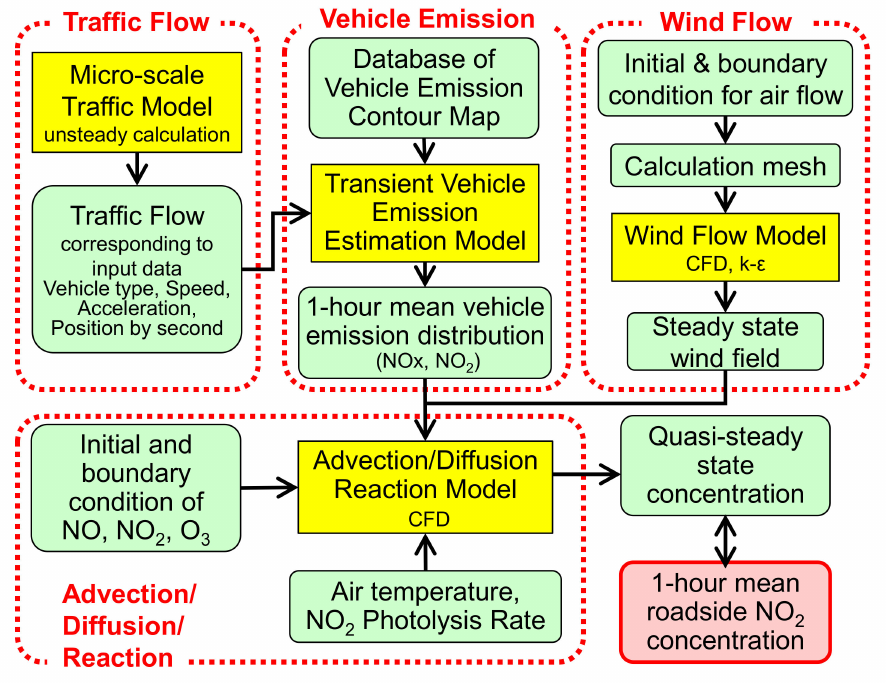
Figure 17. Structure of the Roadside Air Quality